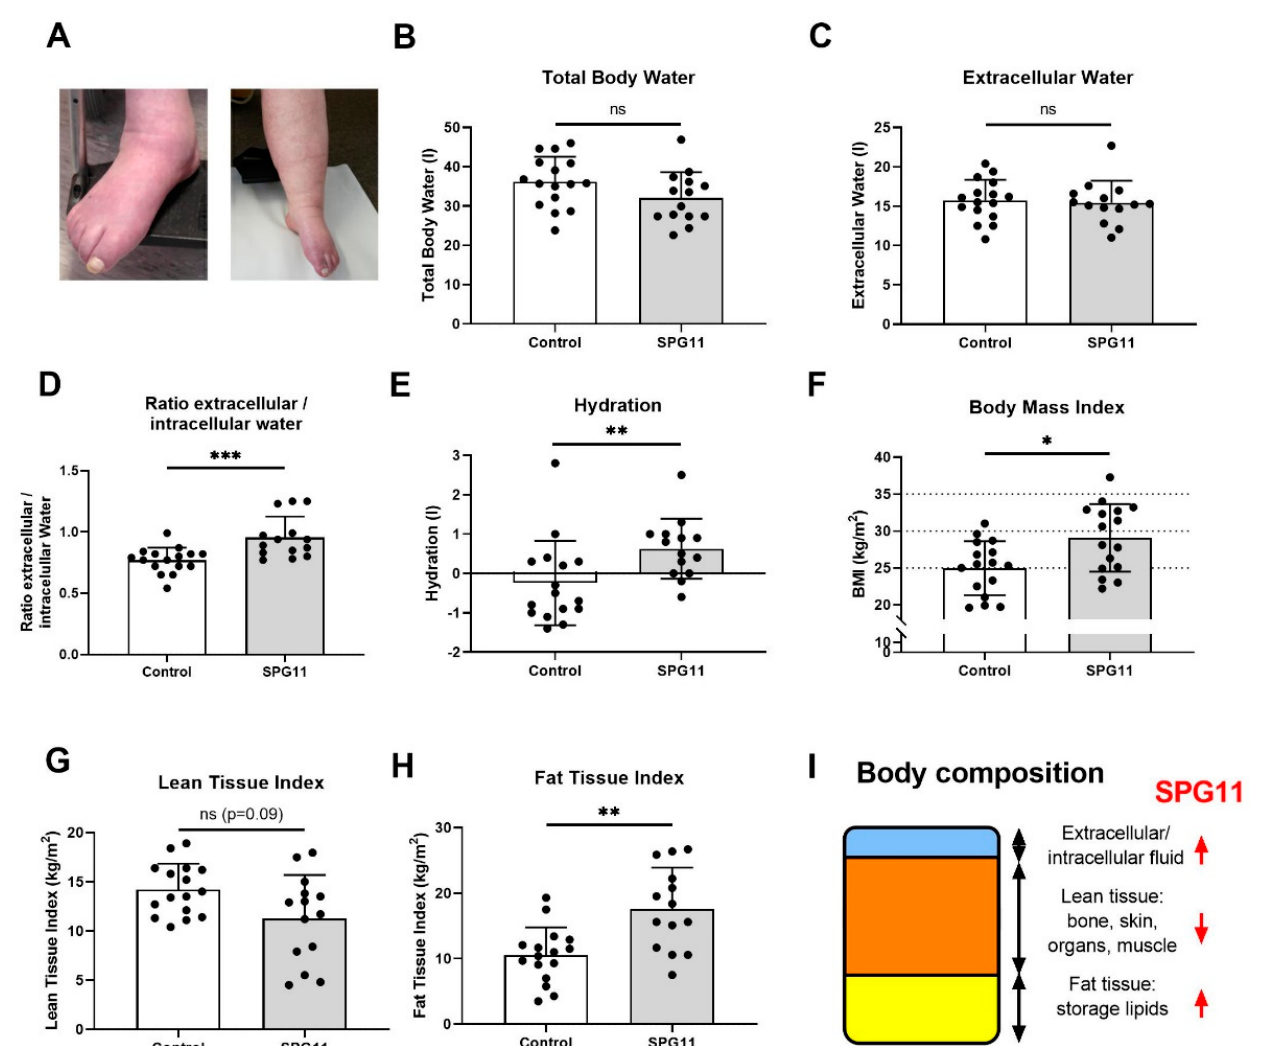
Figure 1. Body composition of SPG11 patients compared to matched healthy controls. ( A ) Representative lower limb lymphedema of late-stage SPG11 patients. Note the blue-livid discoloration and swelling of the calf and feet. ( B – E ) Body fluid distribution derived from bioimpedance spectroscopy comprising ( B ) total body water, ( C ) extracellular water, ( D ) the ratio of extracellular and intracellular water, and ( E ) total hydration state. ( F ) Body mass index (BMI) was increased in 12 out of 16 SPG11 patients. ( G ) Lean tissue index was reduced in SPG11 (not at a significant level), whereas ( H ) fat tissue index showed a significant increase in SPG11. ( I ) Model of body composition and its changes in SPG11, indicated by red arrows. Bars indicate means ± SD. All groups were compared by Mann–Whitney U tests. ns : not significant, * p < 0.05, ** p < 0.01, *** p < 0.001.